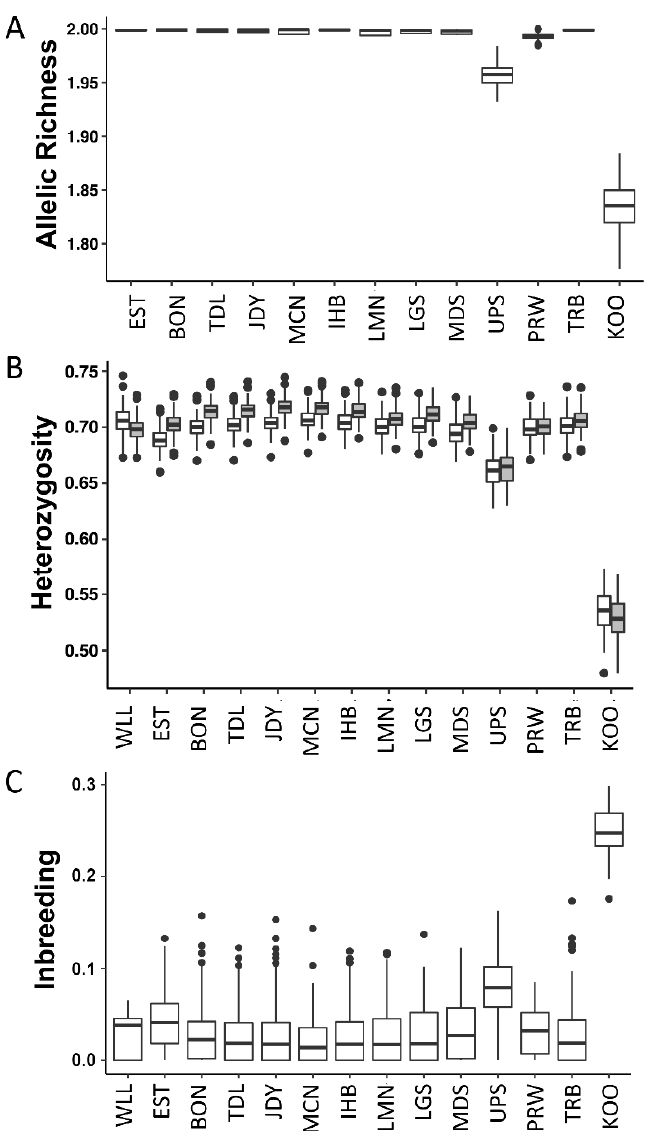
Figure 4. Genetic diversity of white sturgeon collections in the Columbia River Basin. ( A ) Jackknife estimates across loci of rarefied allelic richness; Willamette River is omitted due to low sample size. ( B ) Jackknife estimates across loci of heterozygosity (unfilled: observed; filled: expected). ( C ) Maximum likelihood estimates of inbreeding across individuals. Labels follow Table 1.